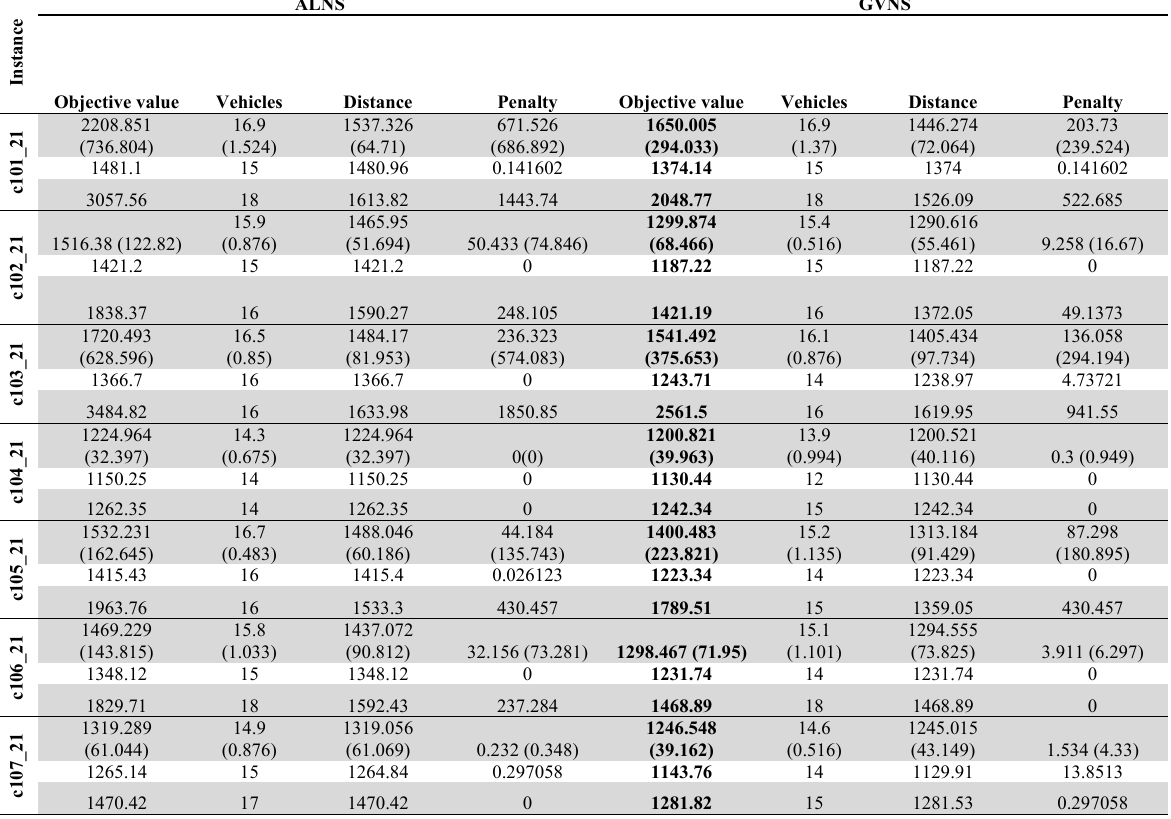
The obtained results for larger-sized